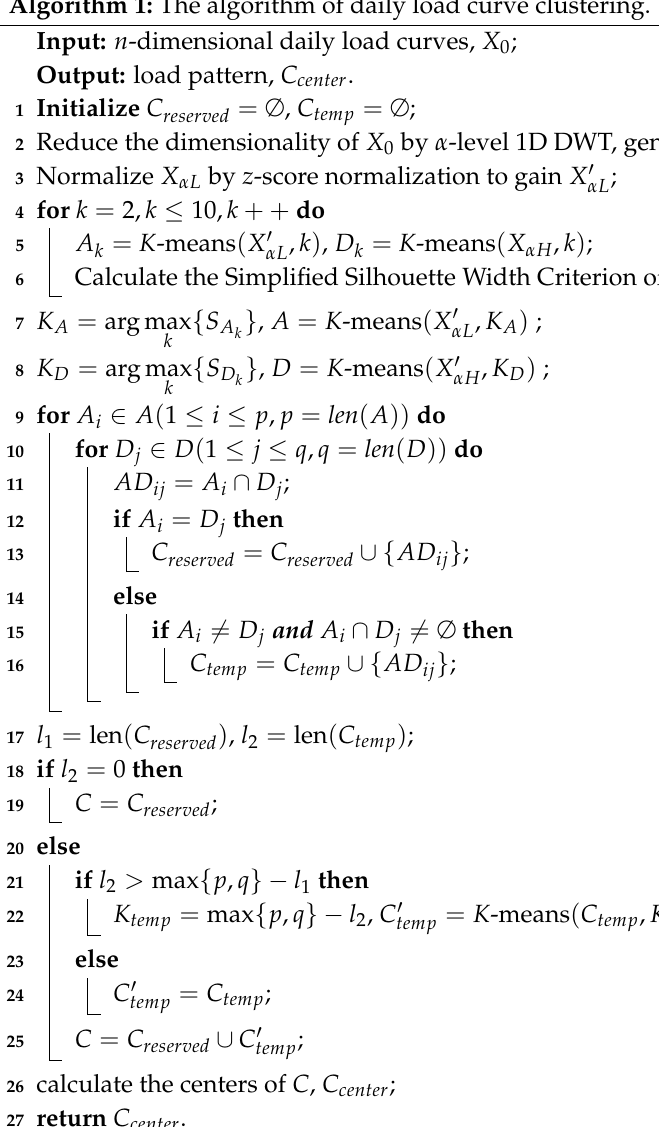
Algorithm 1: The algorithm of daily load curve